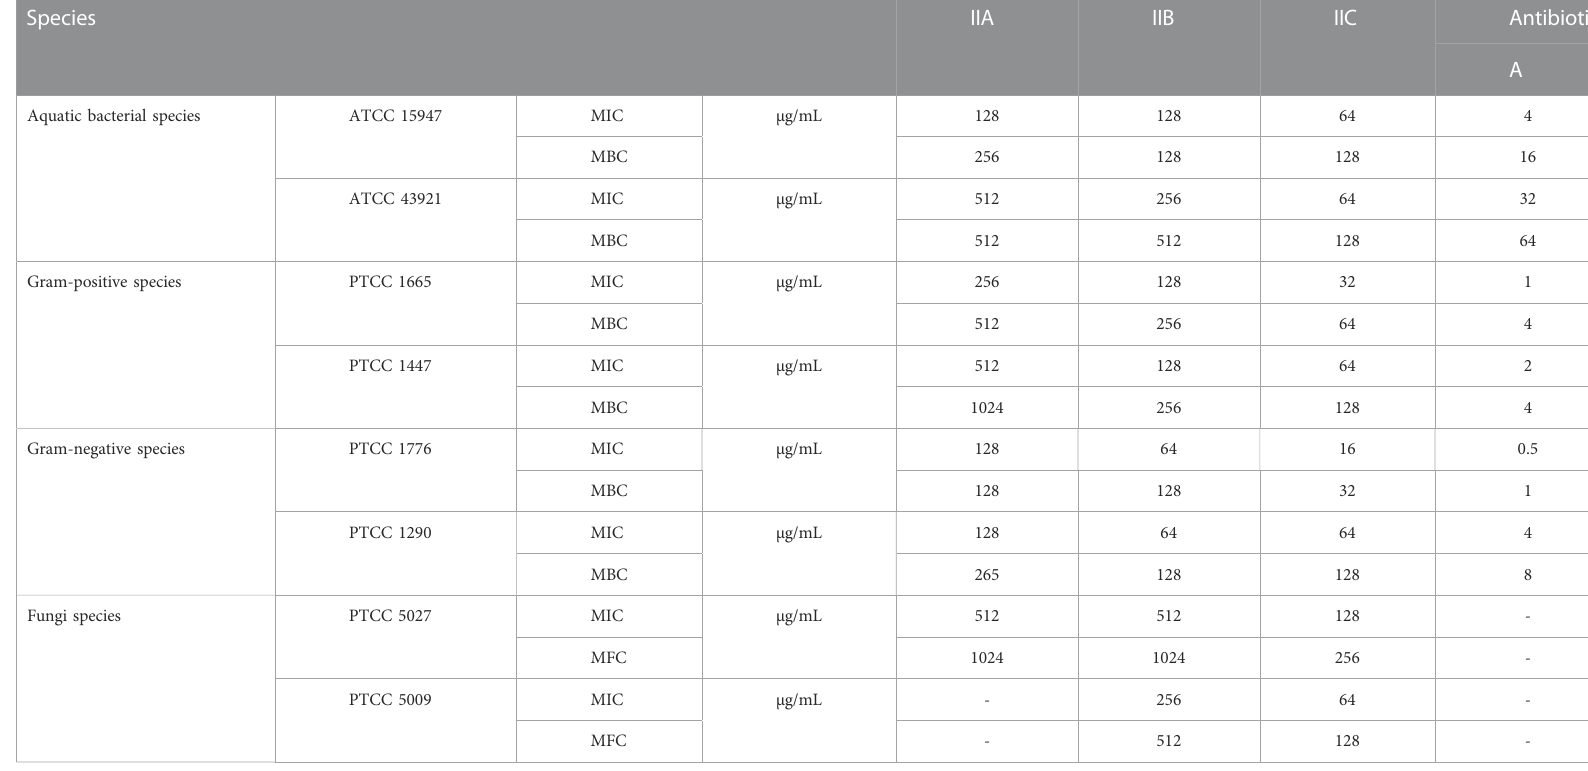
TABLE 5 Investigation of antibacterial and antifungal activity of the three derivatives. Species